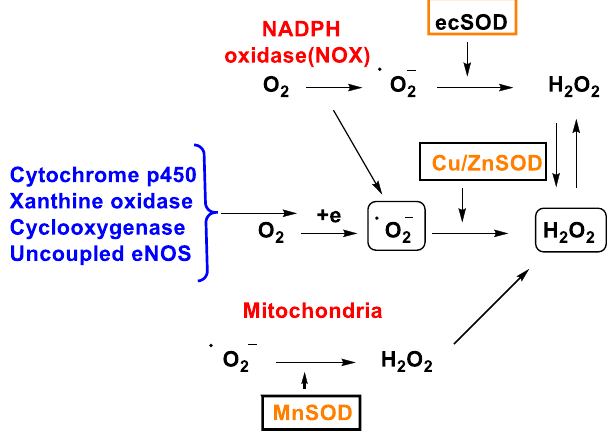
Figure 2. H 2 O 2 production through different mechanisms.